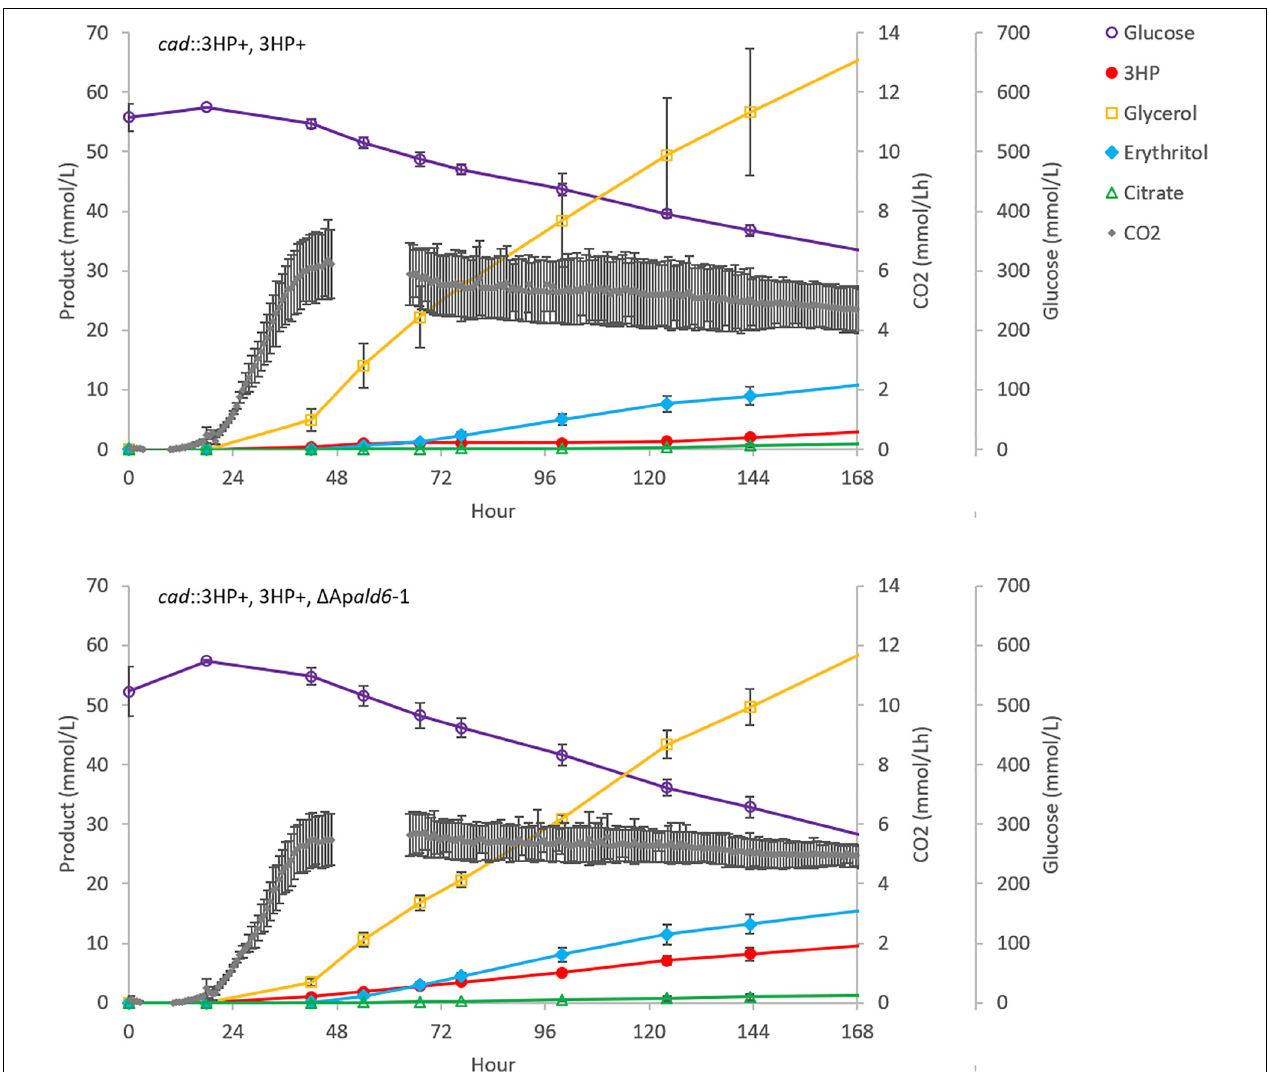
FIGURE 5 | Deletion of A pald6 increases 3HP yield at 0.5 L bioreactor scale. Time-course production of 3HP and other detected bioproducts. Error bars represent the standard deviation from three